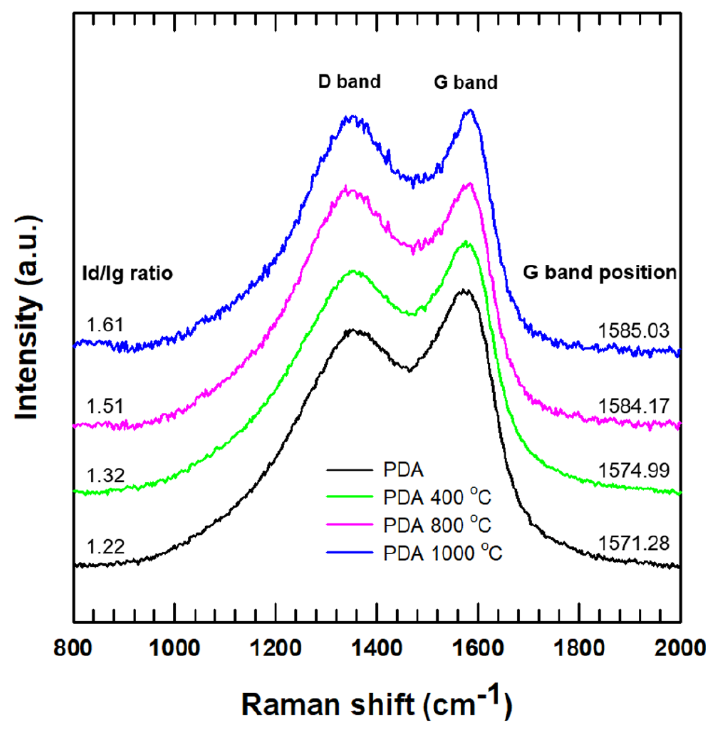
Figure 3. Raman spectrum of carbonized PDA with increasing annealing temperatures.